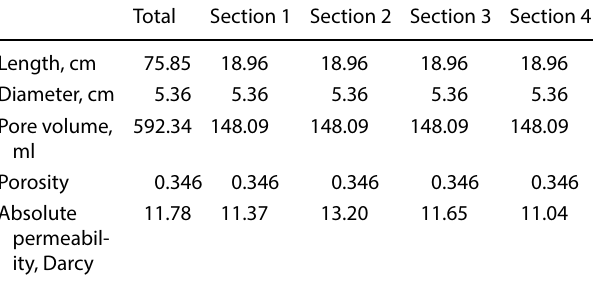
Length, pore volume and porosity for each section were calculated from the total